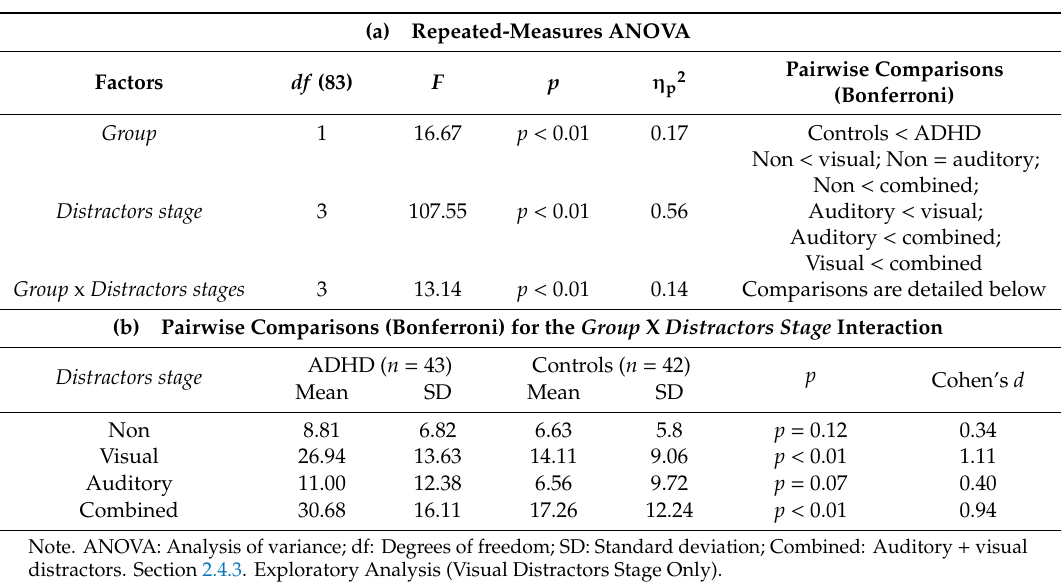
Table 4. Repeated-measures ANOVA for the eye movement distractibility scale: ( a ) Primary analysis; ( b ) post hoc analysis of the interaction e ff ect using multiple pairwise comparisons with a Bonferroni correction.